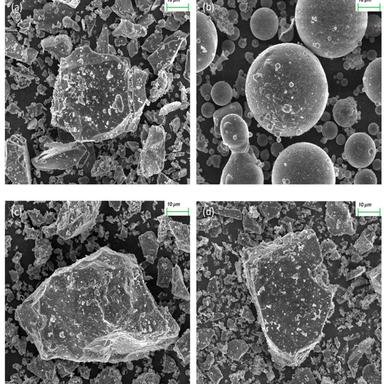
Morphology of raw materials used in this study (1000×magnification, with an accelerating voltage of 10 kV) (a) PC; (b) FA; (c) BFS; (d) MQ.